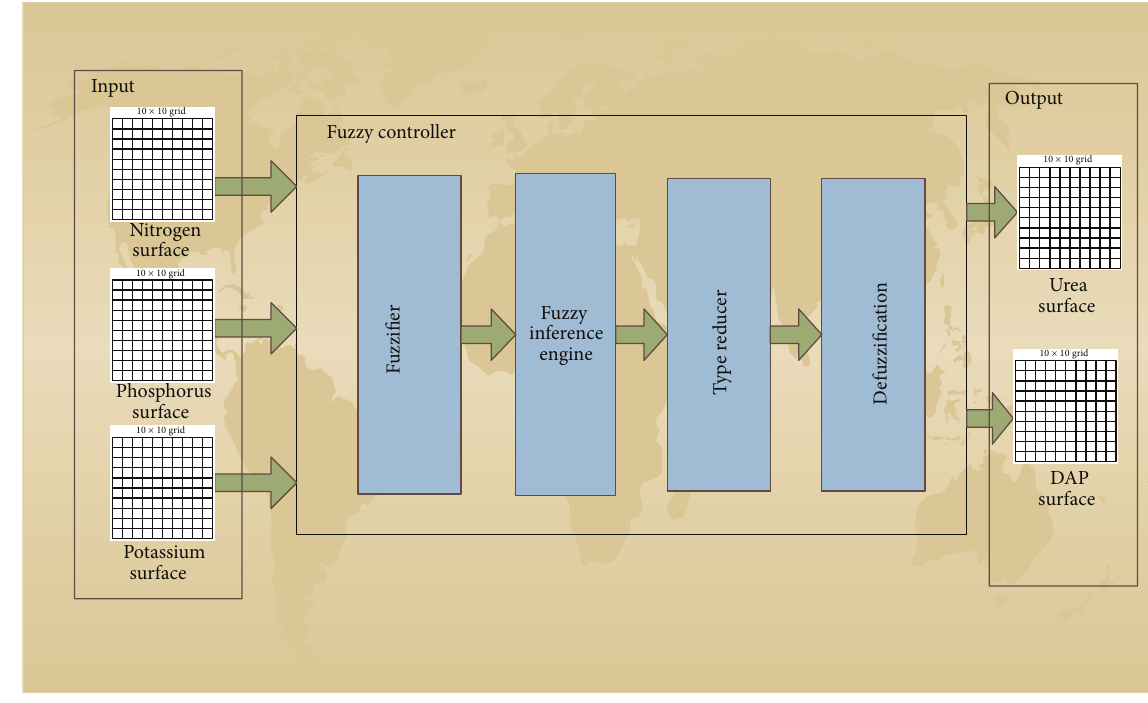
Figure 1: Basic structure of our system.